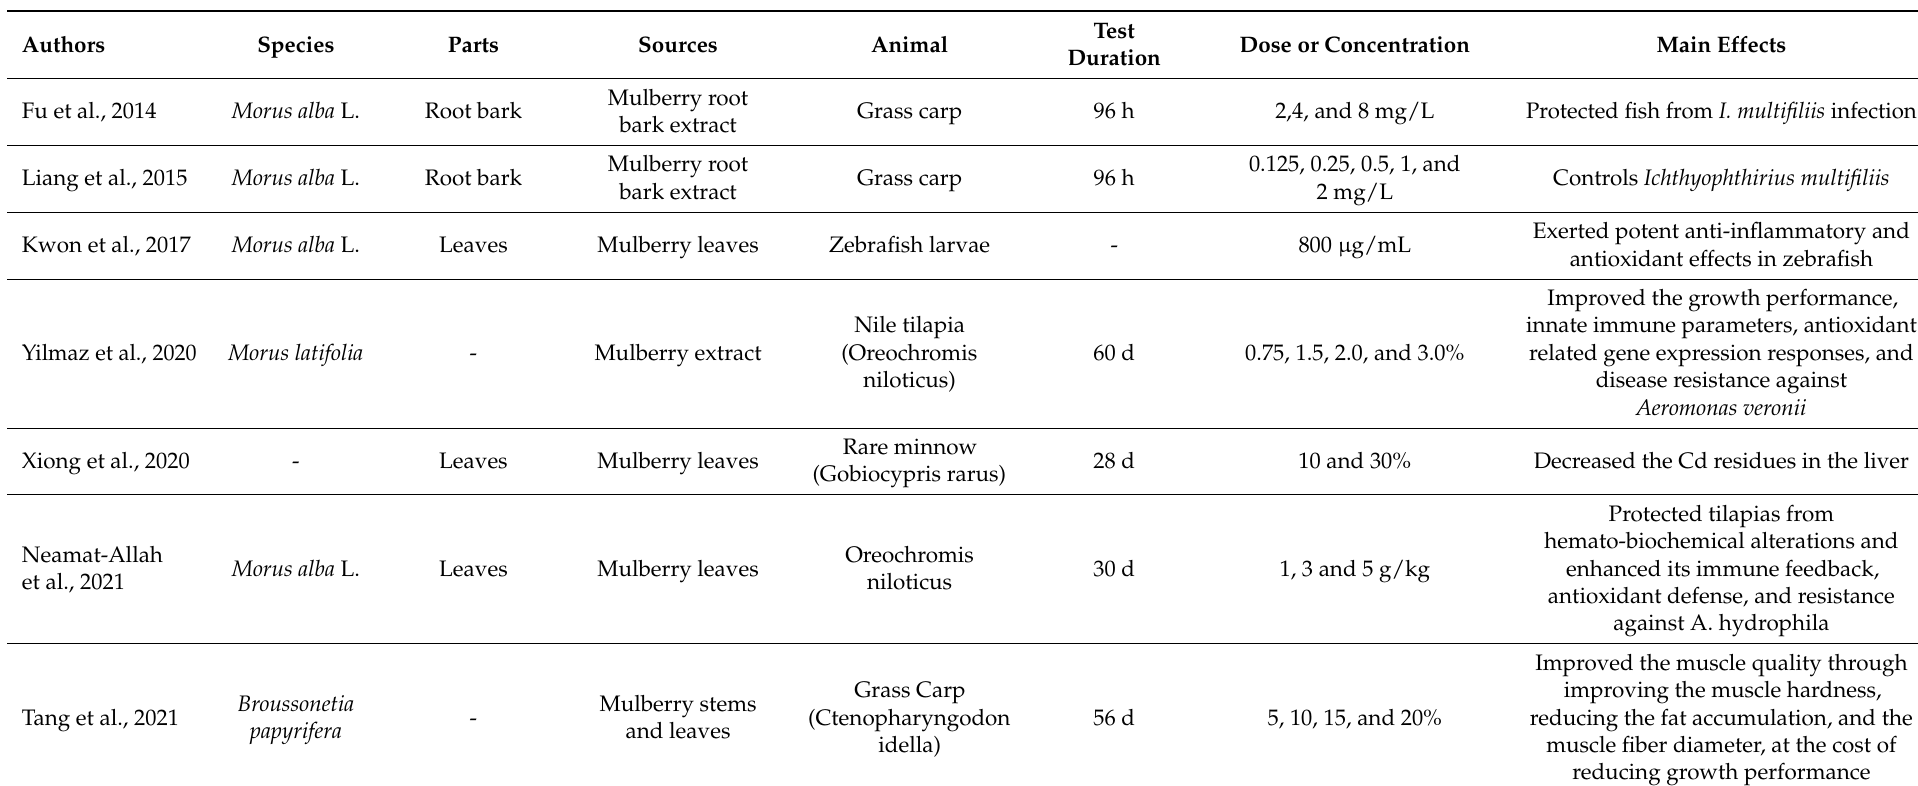
Table 6. The application of mulberry tree extracts on